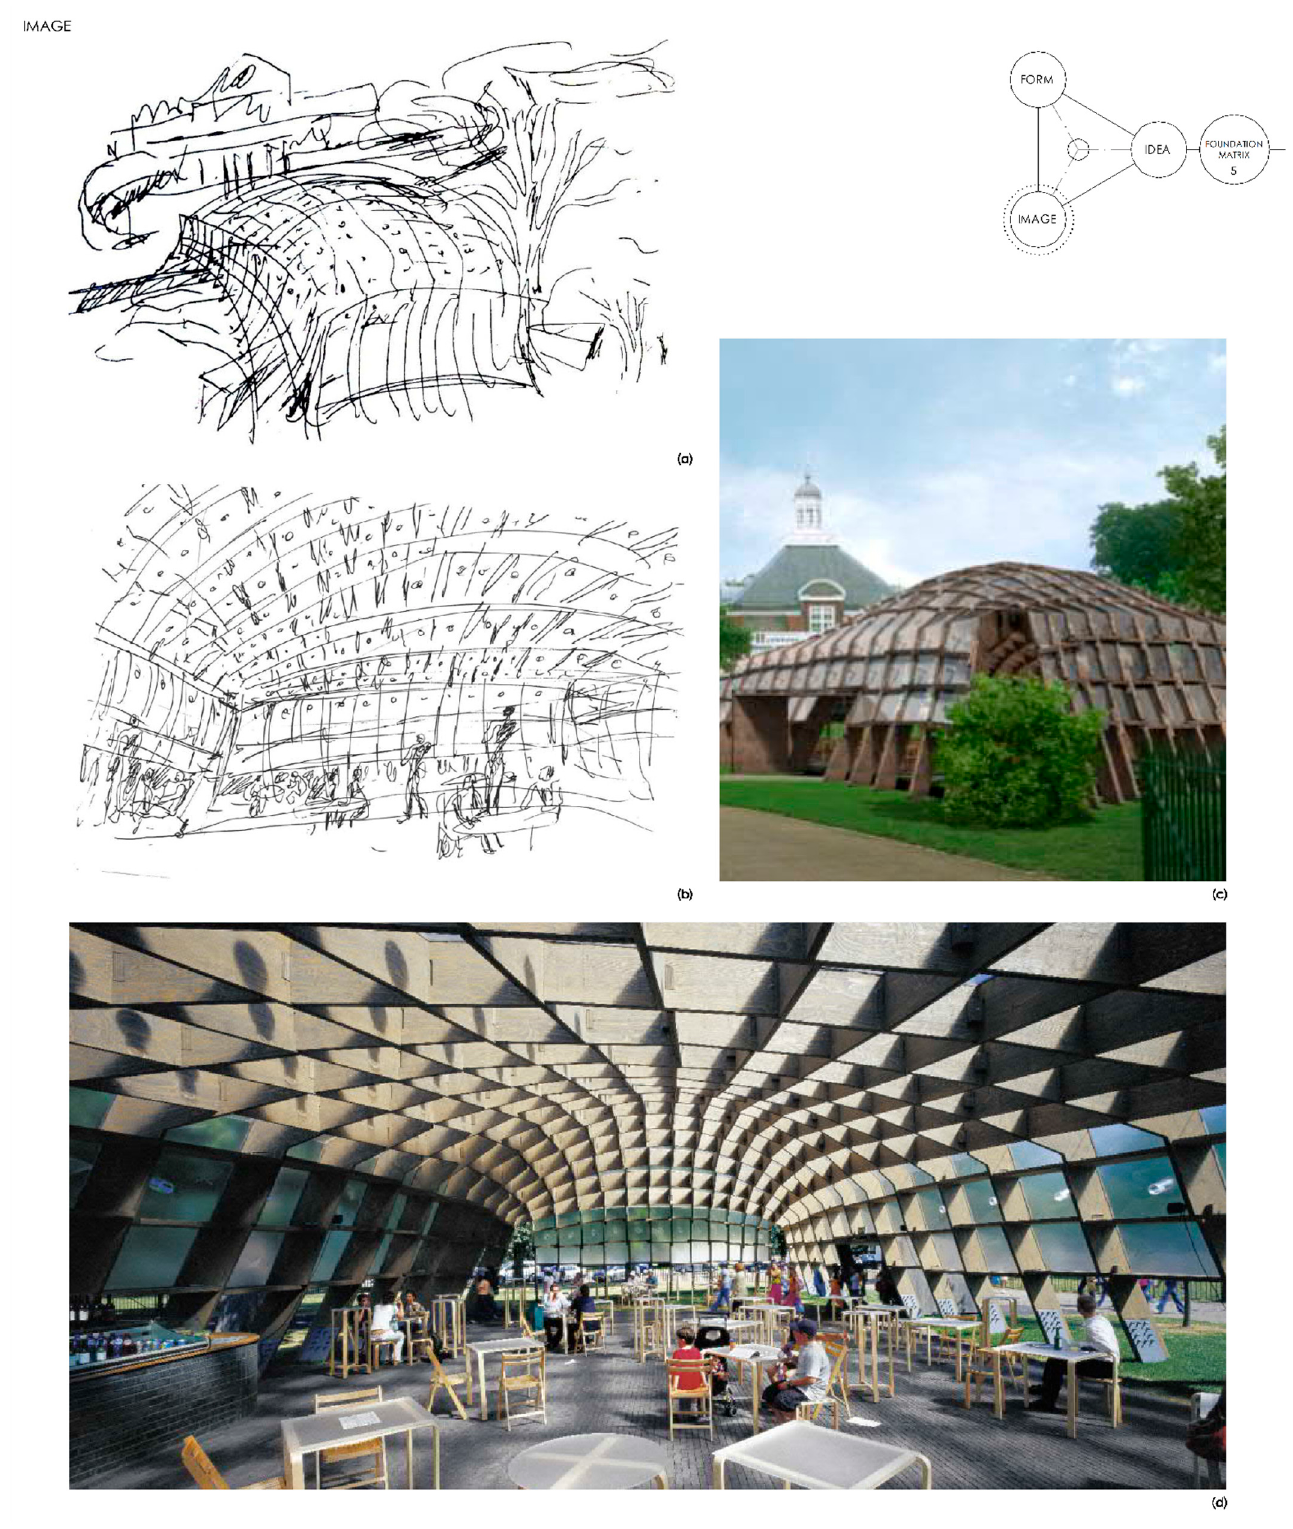
Figure 10. Foundation matrix 5. ( a , b ) Sketches by Siza [72]; ( c , d ) Serpentine 2005 images [73].